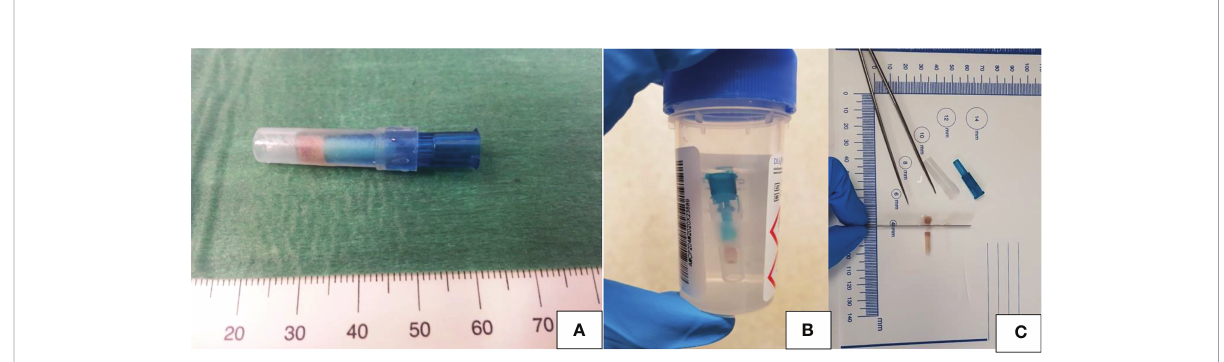
FIGURE 2 (A – C) Cytofoam core sampling: schematic illustration of the sample and of its processation. (A) Foam structure of the CFCS protected by a plastic guard cap before fi xation; (B) CFCS sample fi xation in 10% neutral buffered formalin; (C) Sections of the CFCS sample ready to be embedded in a paraf fi n